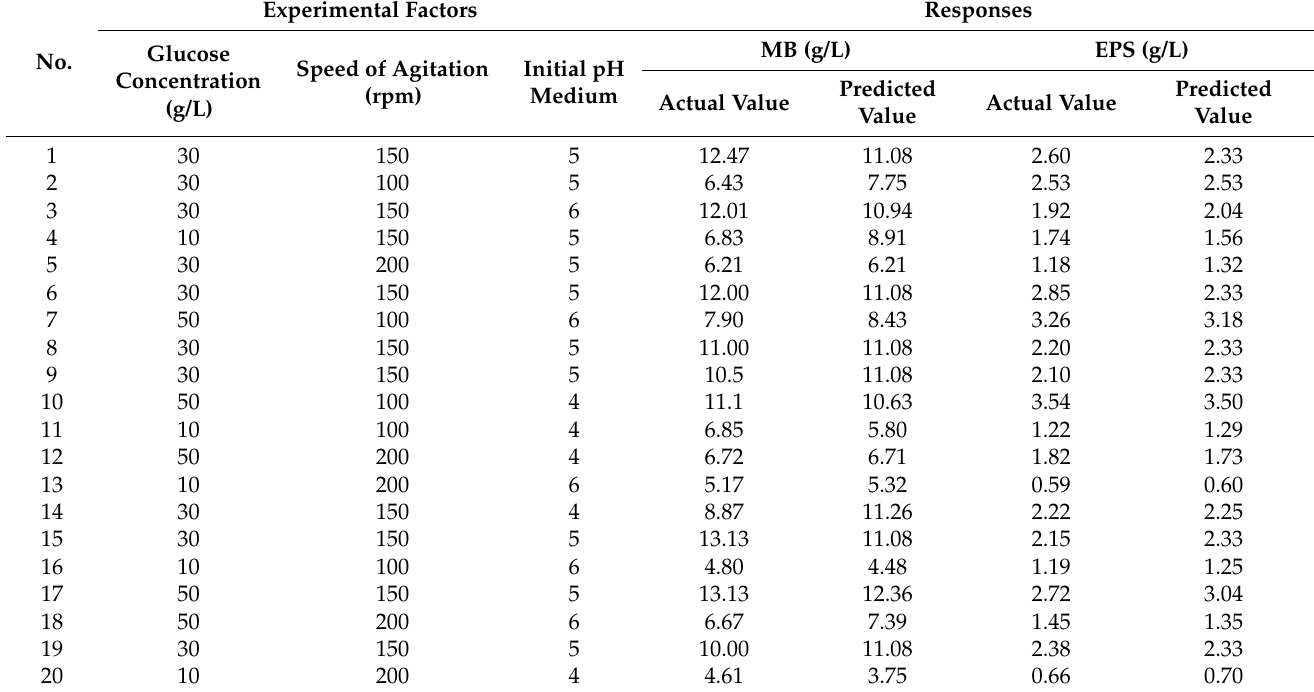
Table 2. RSM with the CCD matrix and the result of the MB and EPS